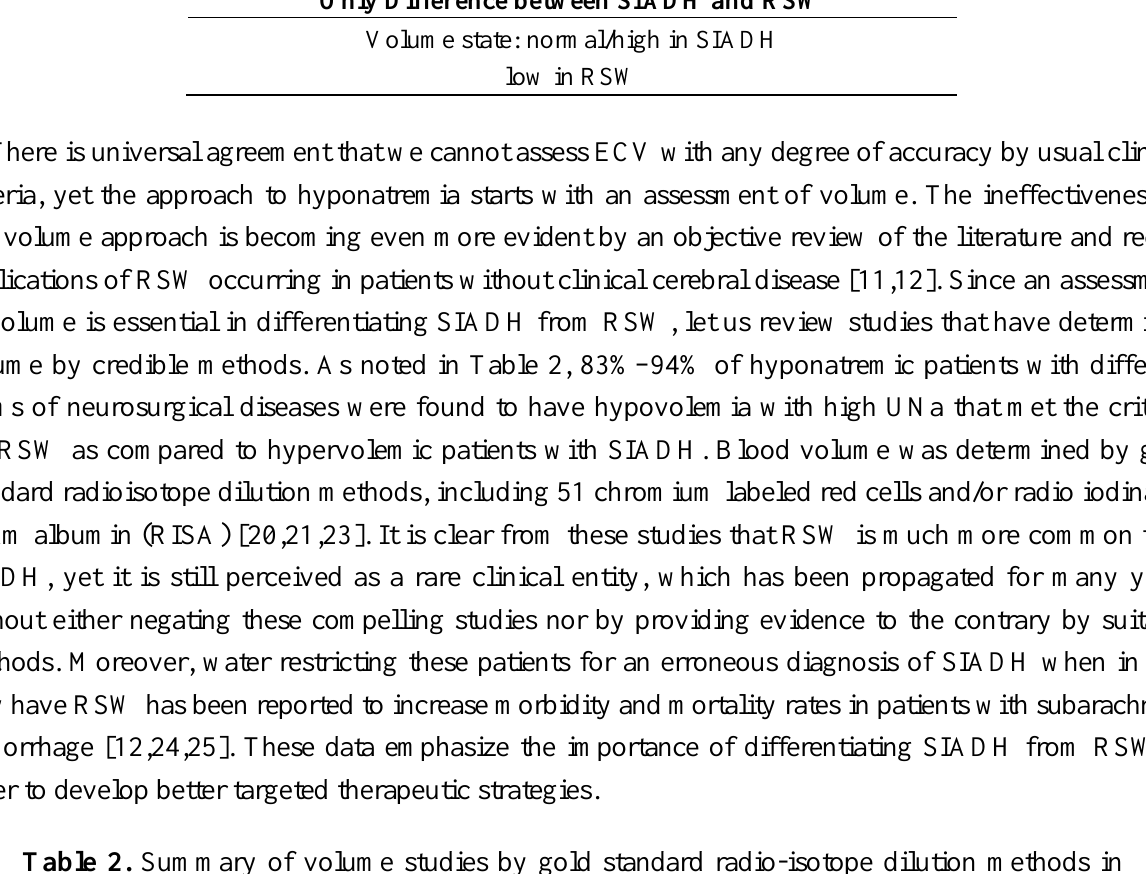
Table 2. Summary of volume studies by gold standard radio-isotope dilution methods in hyponatremic neurosurgical patients. (Note: RSW is much more common than SIADH). Author